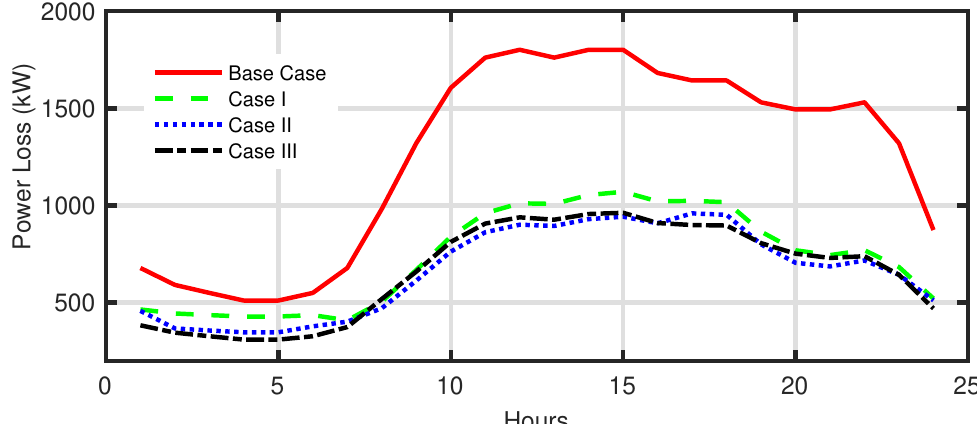
Figure 10. Hourly active power loss of 108-bus Indian distribution